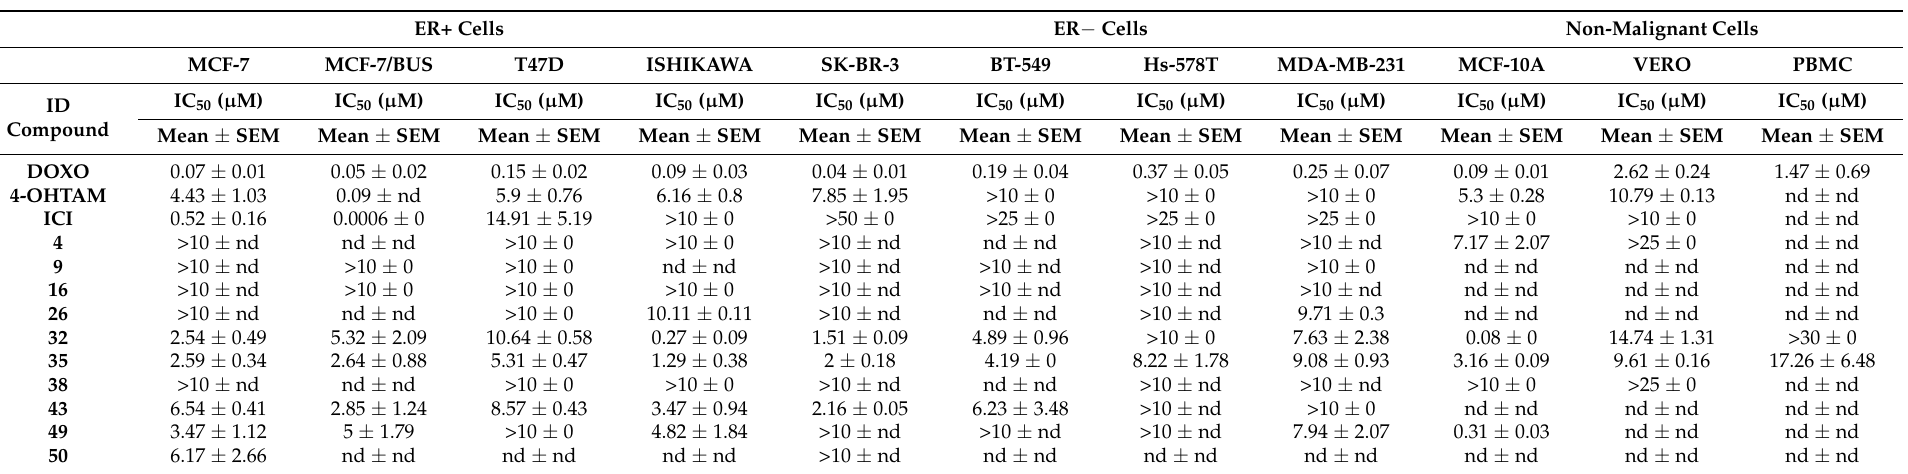
Table 1. Effects of the most active 5-hydroxy-2 H -pyrrol-2-ones on the viability of ER breast cancer (ER+ and ER − ), ER+ endometrial and non-malignant cells. Cells were treated with vehicle (VEH, 0.05% DMSO), doxorubicin (DOXO; 0.01–5 µ M), ICI 182,780 (ICI; 0.01–50 µ M), 4-hydroxy-tamoxifen (4-OHTAM; 0.01–10 µ M) or compounds (0.01–10 µ M) for 72 h in the presence of 10%FBS growth media. The percentage of cell viability related to the VEH-treated cells was assessed by MTT assay as described in Materials and Methods. The calculated IC 50 values are expressed as mean ± SEM from at least duplicate independent experiments, where each compound concentration was assessed in triplicate; nd indicates a non-determined IC 50